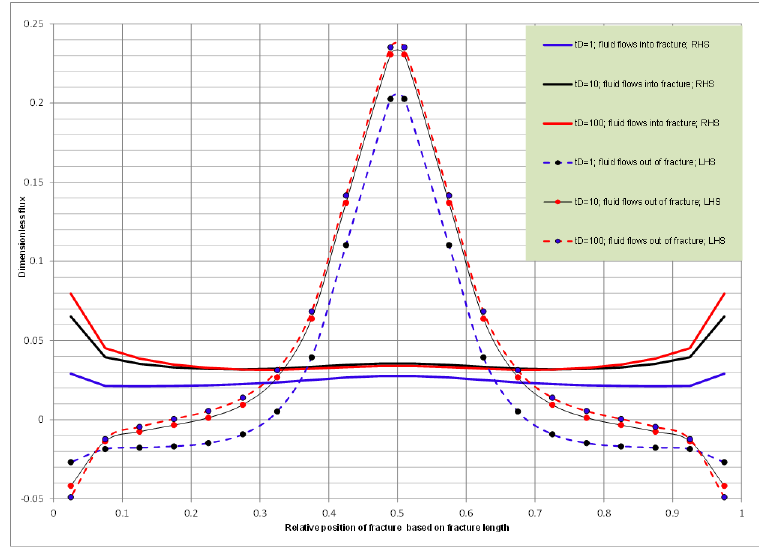
Figure 11. Definitions of ( a ) the LHS and the RHS of the isolated fracture faces and ( b ) the positive flow direction for flowing flux.